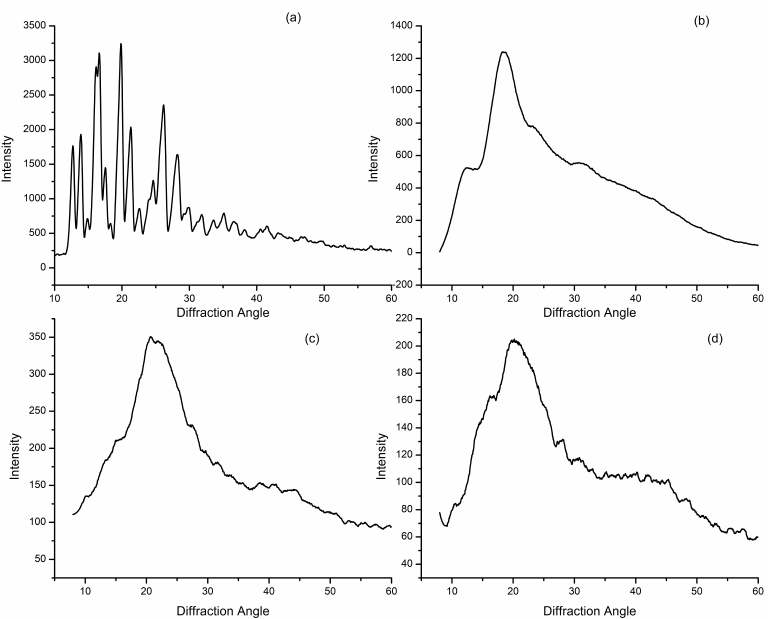
Figure 7. XRD diffractogram of VRC ( a ), HP β CD ( b ), Blank ( c ), and Loaded HP β CD based polymeric nanobeads ( d ).